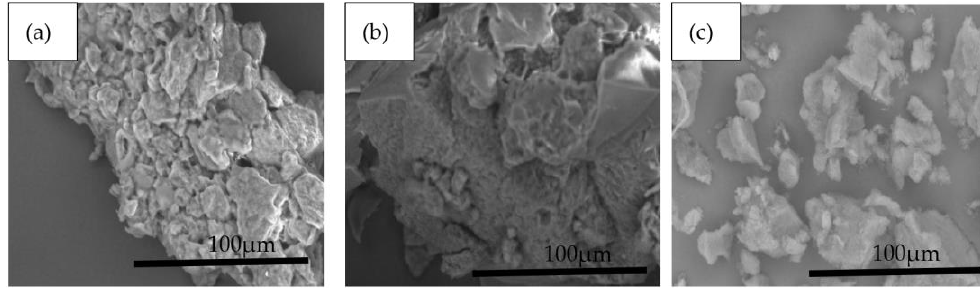
Figure 5. SEM images of imprinted polymer with ( a ) 10% DMSO, ( b ) 25% DMSO, and ( c ) 75% DMSO (Mag: 1.0K). Table 3. BET specific surface area, specific pore volume, and average pore diameter for different porogenic solvent